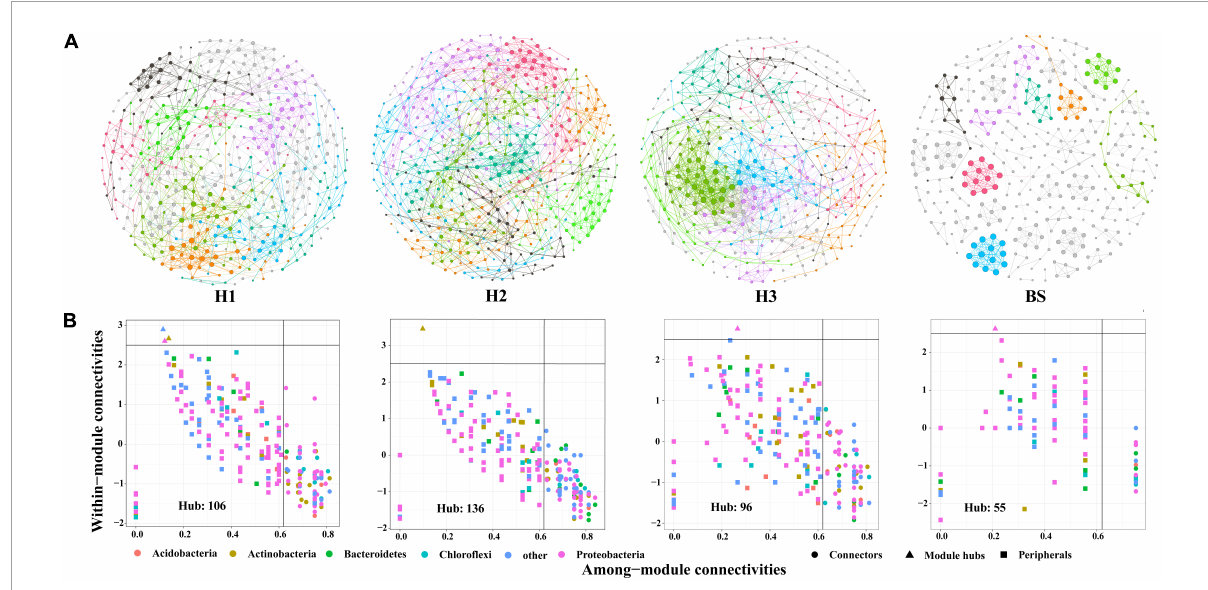
FIGURE4 The co-occurrence networks (A) and hub nodes (B) of bacteria in rhizosphere and bulk soils. Different colors in the network represent different modules.